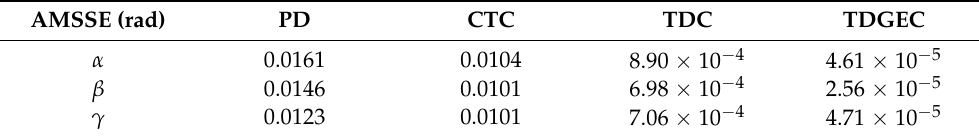
Table 3. AMSSE values.